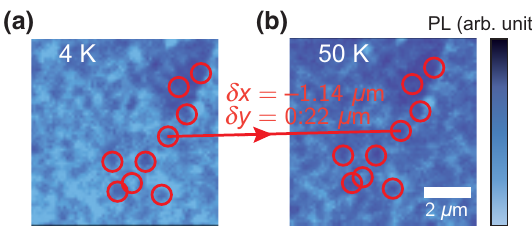
FIG. 17. Drift correction. (a) PL map at 4 K. (b) PL map at 50 K. Common features detected with the SIFT algorithm are encir- cled. The arrow linking one of the pairs is shown as a guide to the eye. We apply a drift correction corresponding to the average displacement of all pairs of common